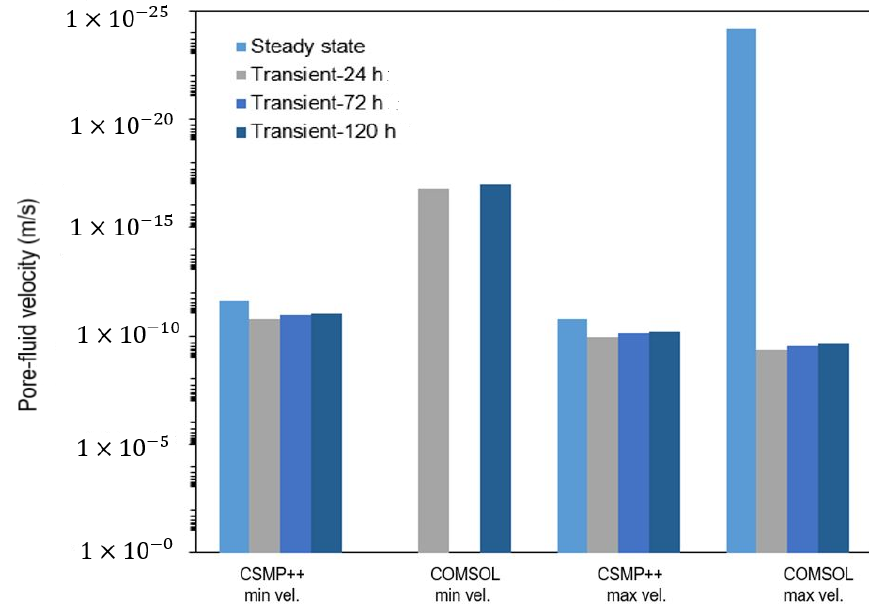
Figure 14. Comparison of pore-fluid velocities computed using CSMP++ and COMSOL under the chemo-thermo-poroelastic framework using the 2DF and COMSOL 2D